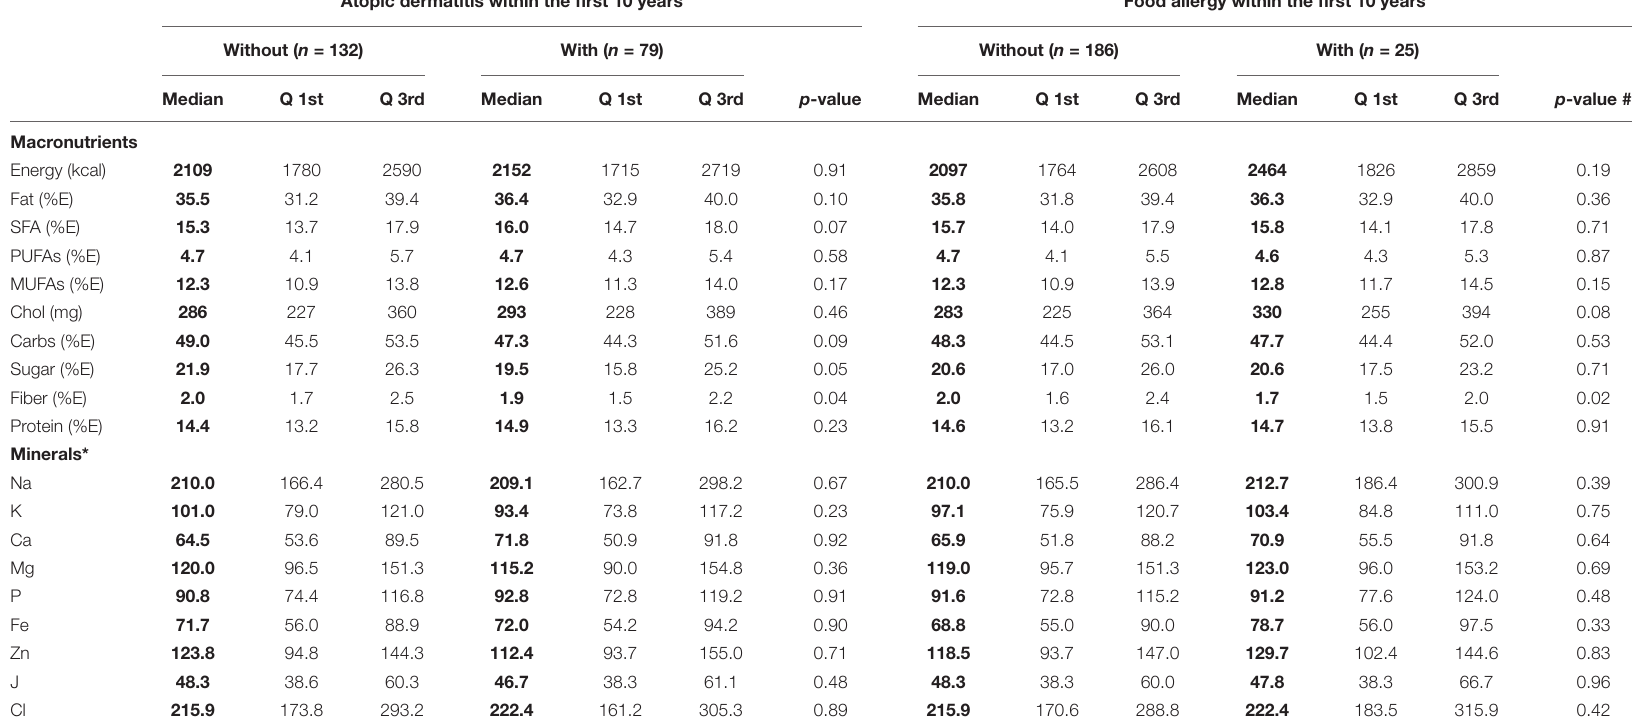
TABLE 2 | Single nutrients and atopic outcomes. Atopic dermatitis within the first 10